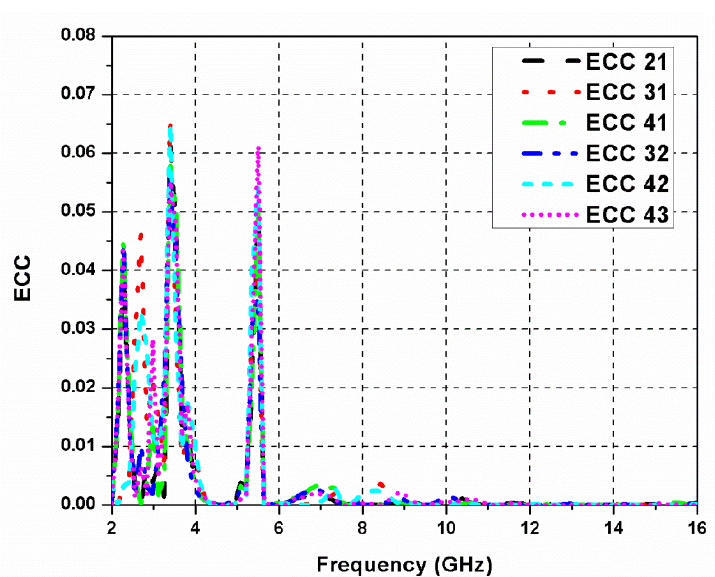
Figure 10. Current distributions at ( a ) 3.5 GHz; ( b ) 5.5 GHz.